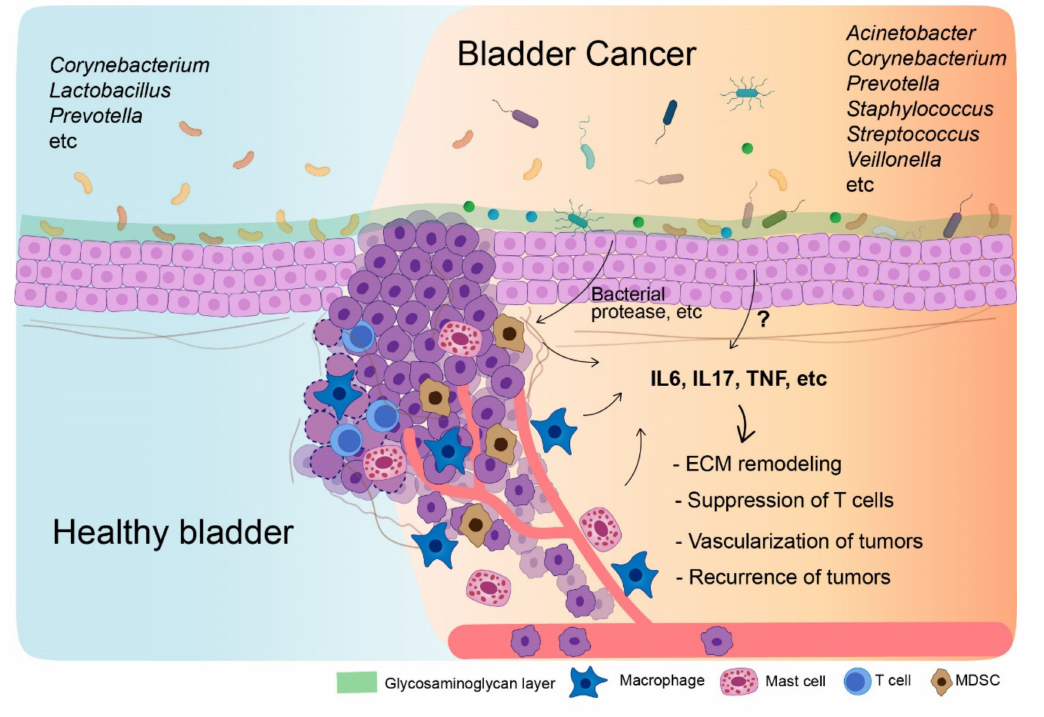
Figure 1. The interaction of urinary microbiota with bladder cancer cells and immune cells. The illustration depicts the difference in microbiome between a healthy bladder and a bladder affected by cancer. Microbiota causing dysbiosis in bladder cancer interact directly or indirectly with immune cells by inducing the secretion of various cytokines. These cytokines accelerate the progression of bladder